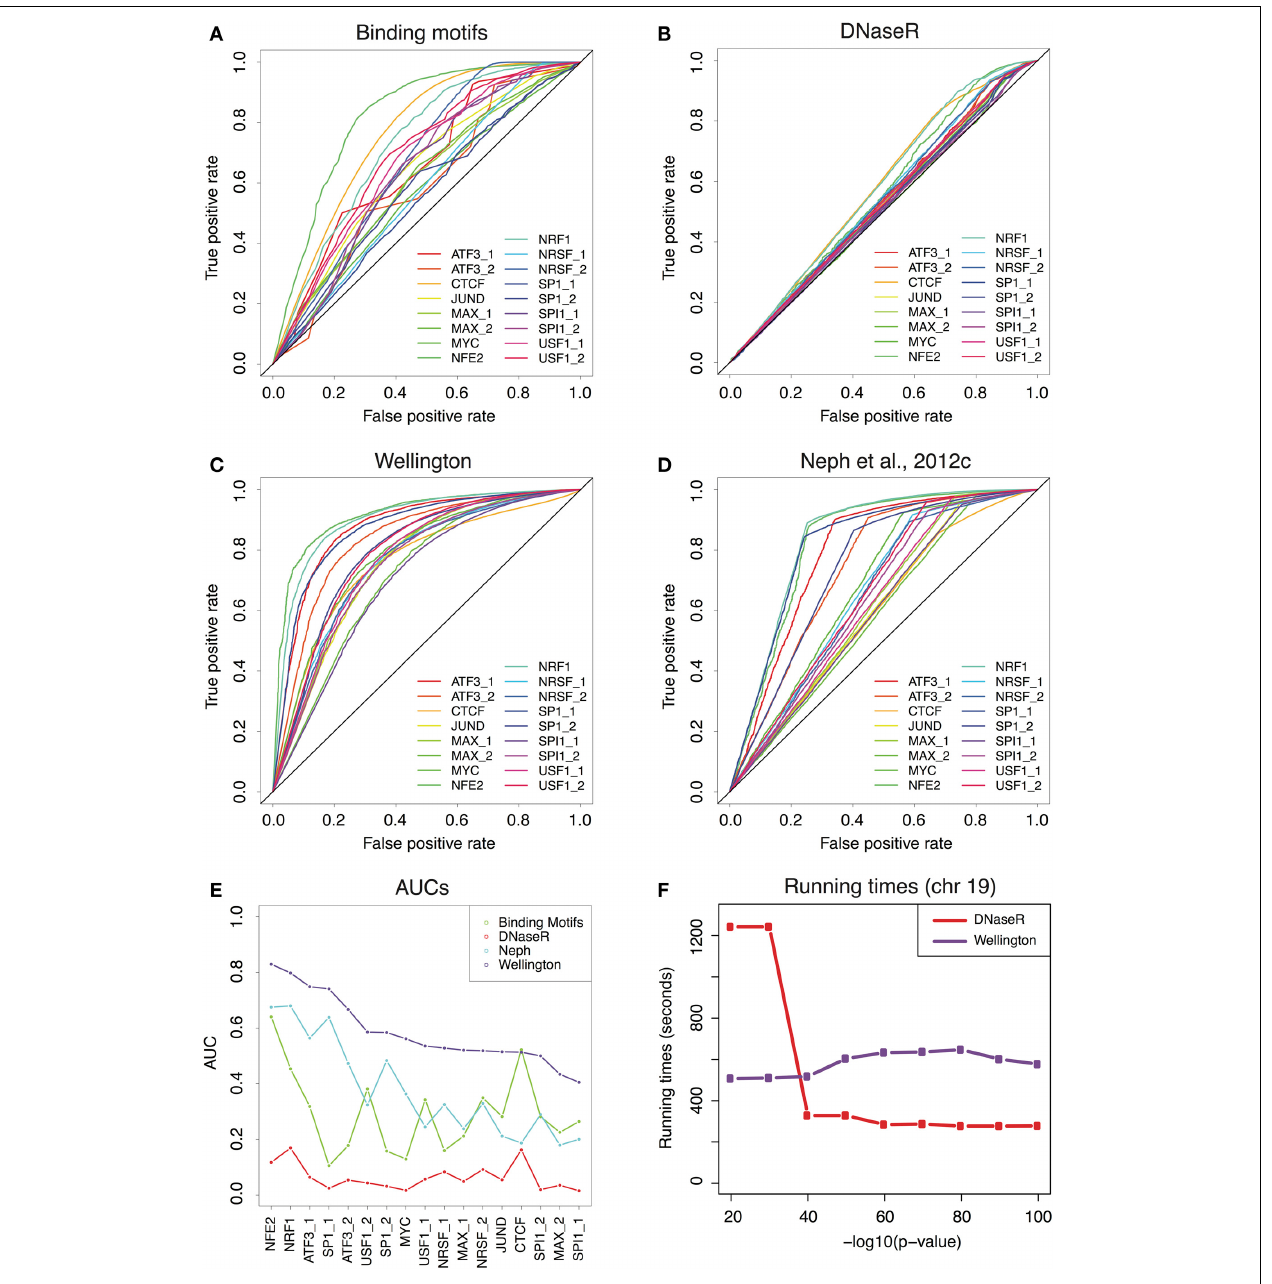
FIGURE 1 | (A) Receiver-Operator Characteristic (ROC) curves for the predictions provided by the binding motifs alone. (B–D) ROCs for the sets of footprints obtained by DNaseR, Wellington and for the set used in Neph et al. (2012c). (E) Area Under the Curve (AUC)